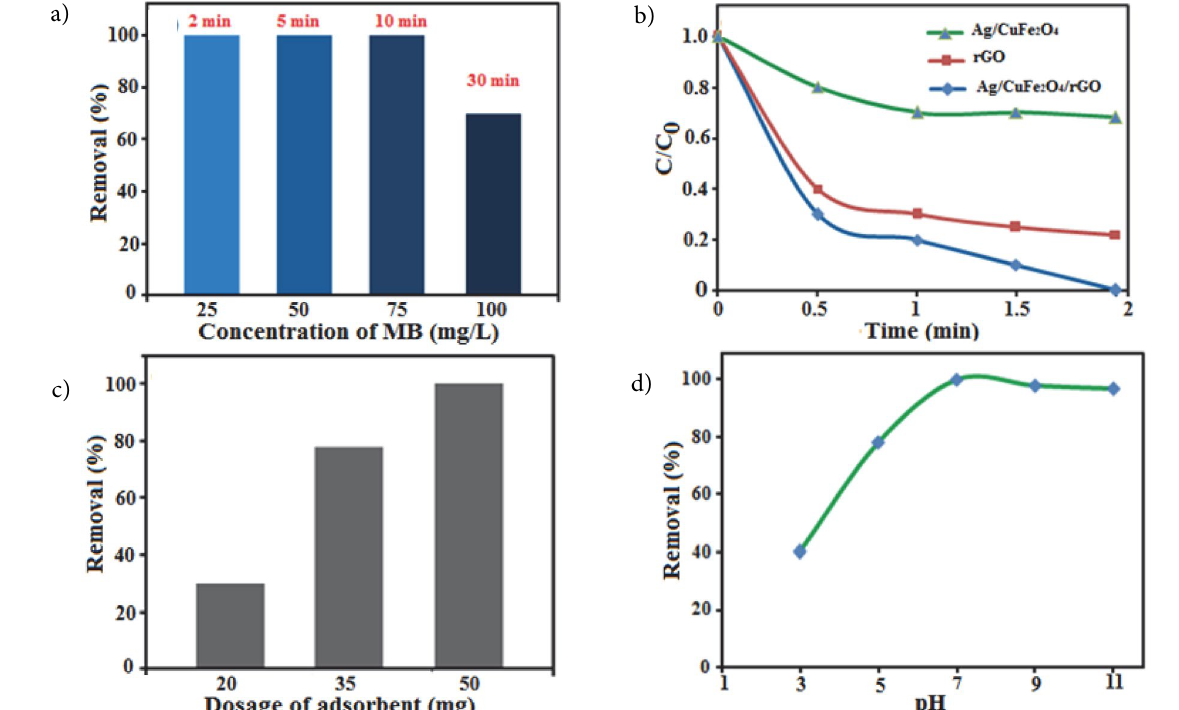
Figure 11 . The adsorption capacity of the Ag/CuFe 2 O 4 /rGO nanocomposite toward MB solutions with different values of (a) concentration of dye, (b) type of adsorbent, (c) dosage of adsorbent and (d)